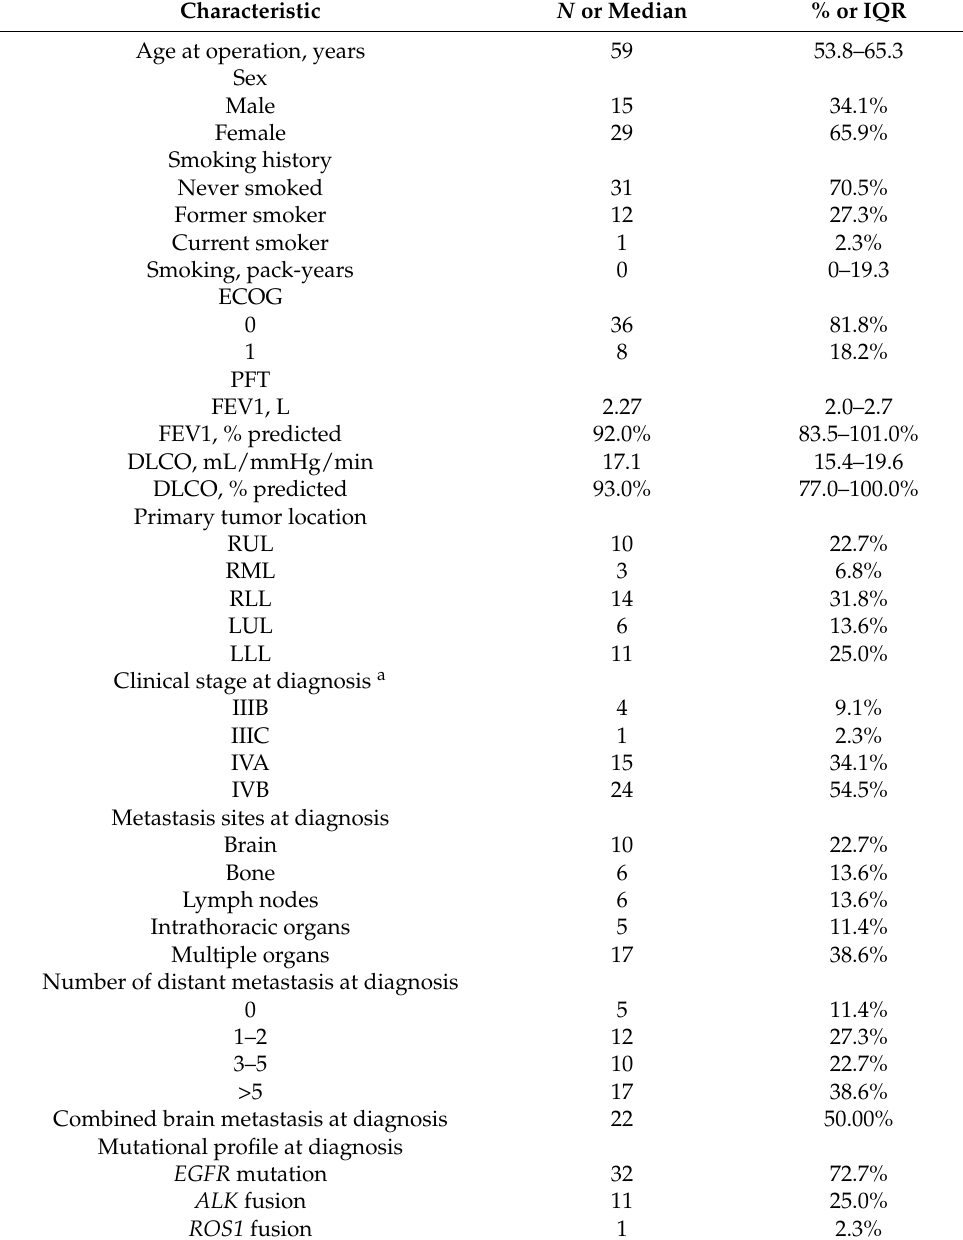
Table 1. Patient